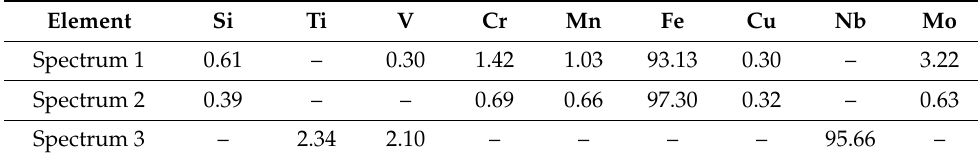
Figure 9. SEM image of microstructure in segregation in CCB. Table 3. Chemical composition of segregation zone in CCB, wt. %.